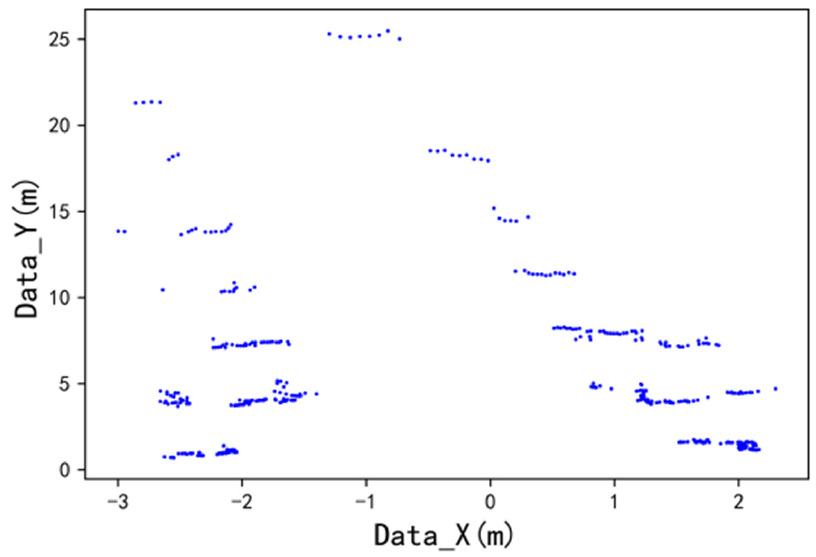
Figure 5. A frame of original data.